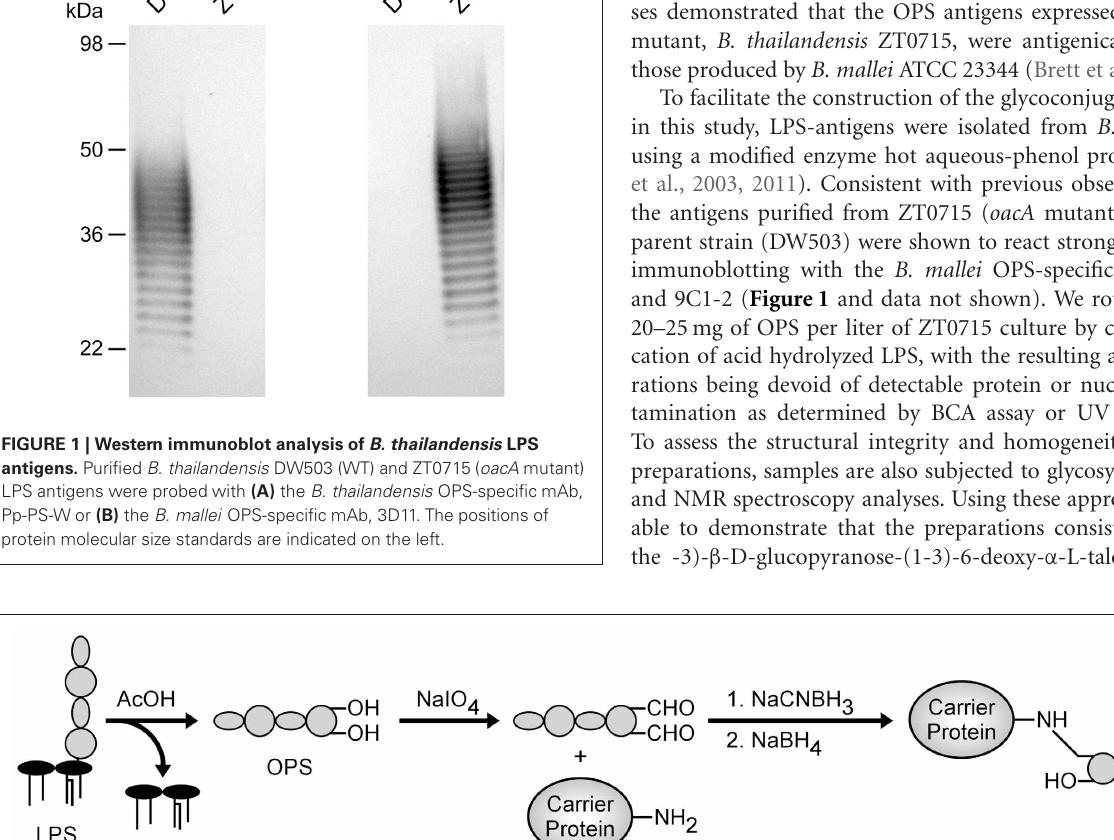
Frontiers in Cellular and Infection